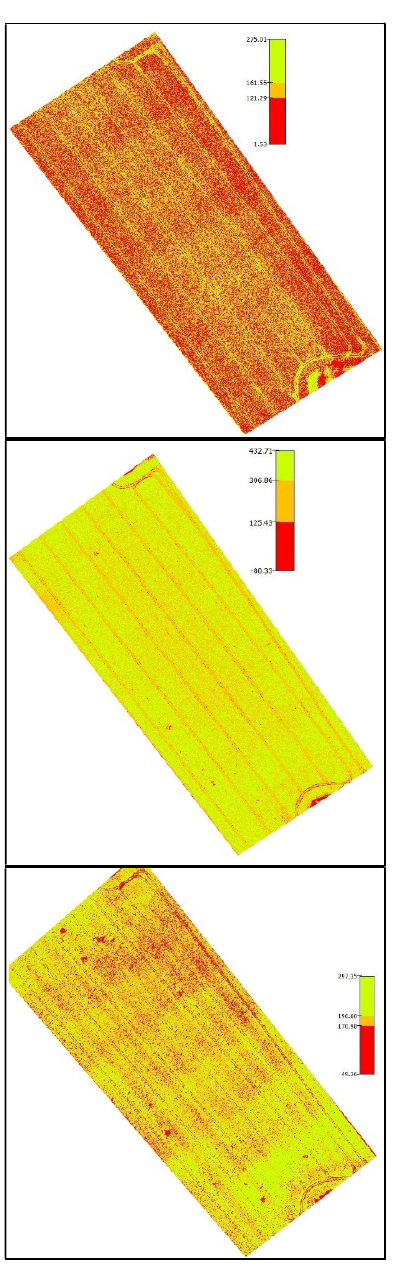
Figure 7– chart of TGI for rape crops; d- rape germinating, e- rape flowering, f- rape ripening.